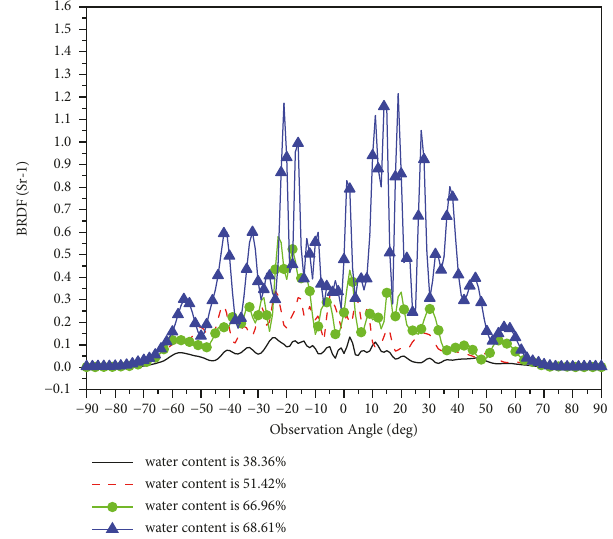
Figure 9: BRDF with different water contents of leaves.